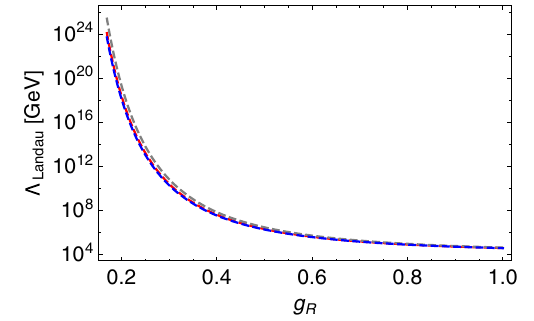
Fig. 4 PossiblepresenceofLandaupolesassociatedwith U ( 1 ) R gauge coupling running. For this plot, we have fixed μ 0 = 10 TeV. Red, gray and blue lines correspond to Dirac seesaw, simplest one-loop and Scotogenic models